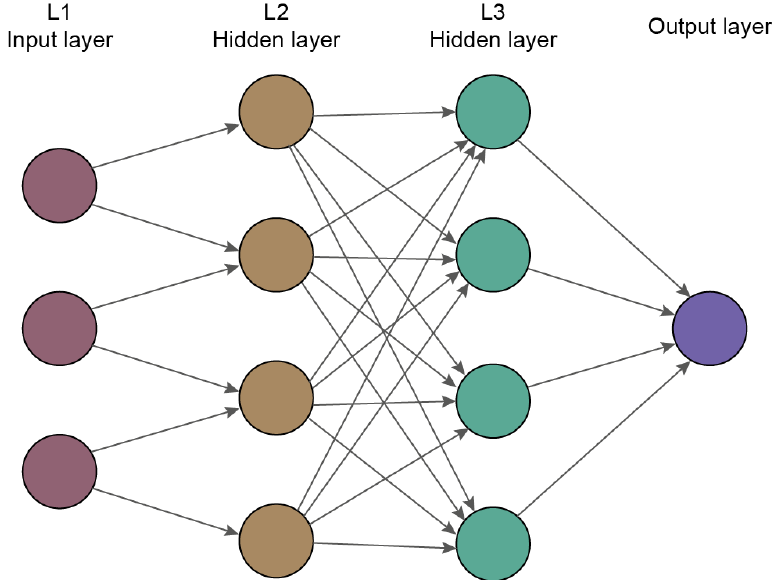
Figure 5. Layers of deep feedforward or feedforward neural network. The statement feedforward means that the information flows from input through some estimation functions to generate the output. Elsewhere exists a feedback neural network, where the information about the output is fed back to the model. Each layer represents a different function—the input layer (L1) with the first function, the hidden layers (L2, L3, …, LX) with the next functions. The depth of the model reflects the connection chain length. In the last output layer, the output value should match the input value approximated by earlier functions.